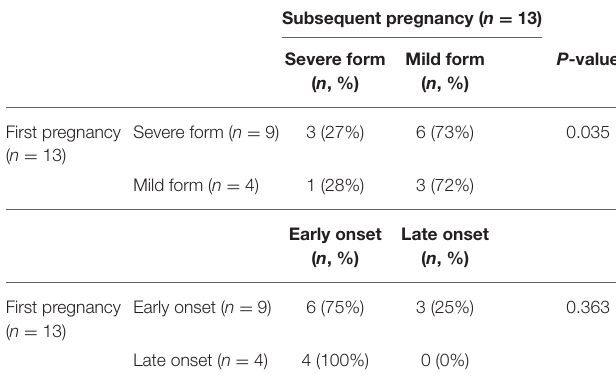
TABLE 2 | The association between severity or the time of onset in previous pre-eclampsia and developing recurrent pre-eclampsia. Previous pre-eclampsia